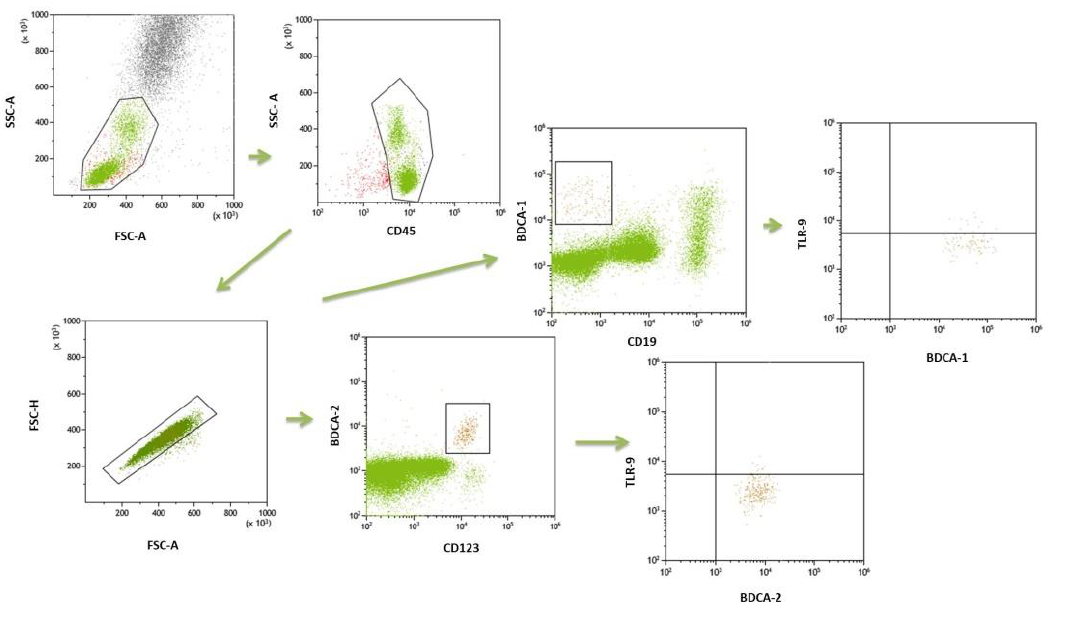
Figure 3. The gate strategy of dendritic cells.